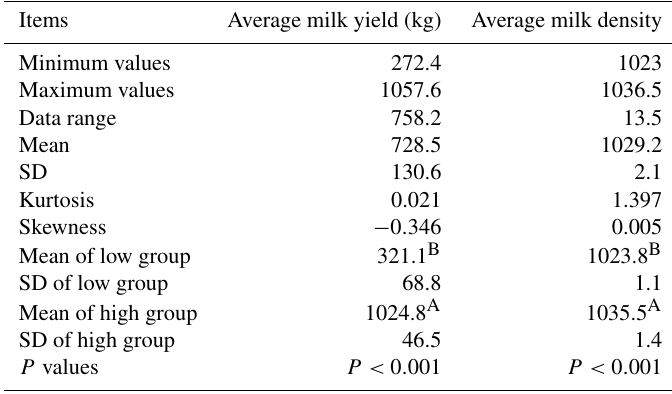
Table 1. Milk performance of the low and high groups of Xinong Saanen dairy goats. Items